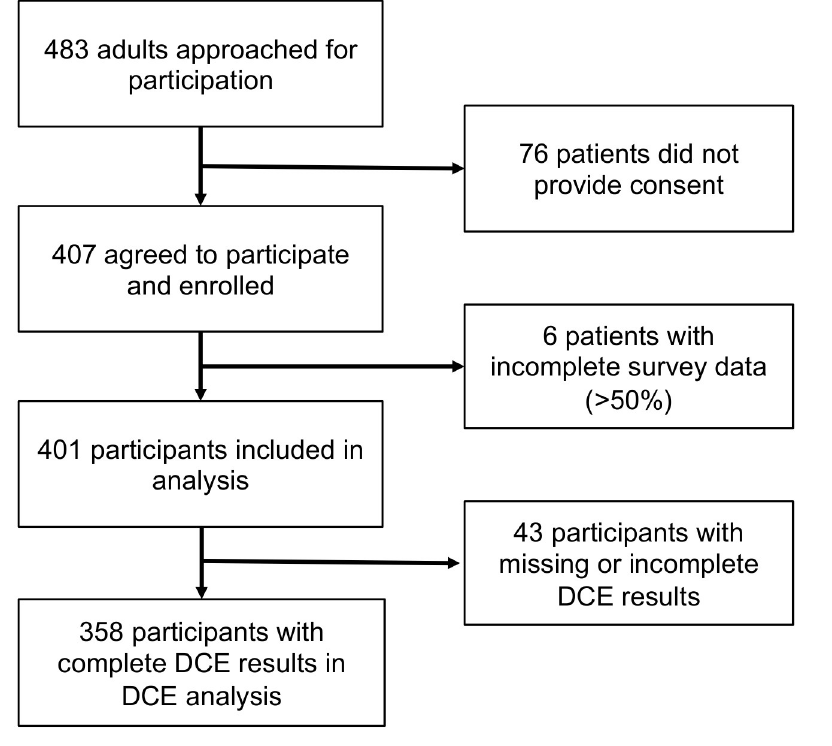
Fig 1. Study flow